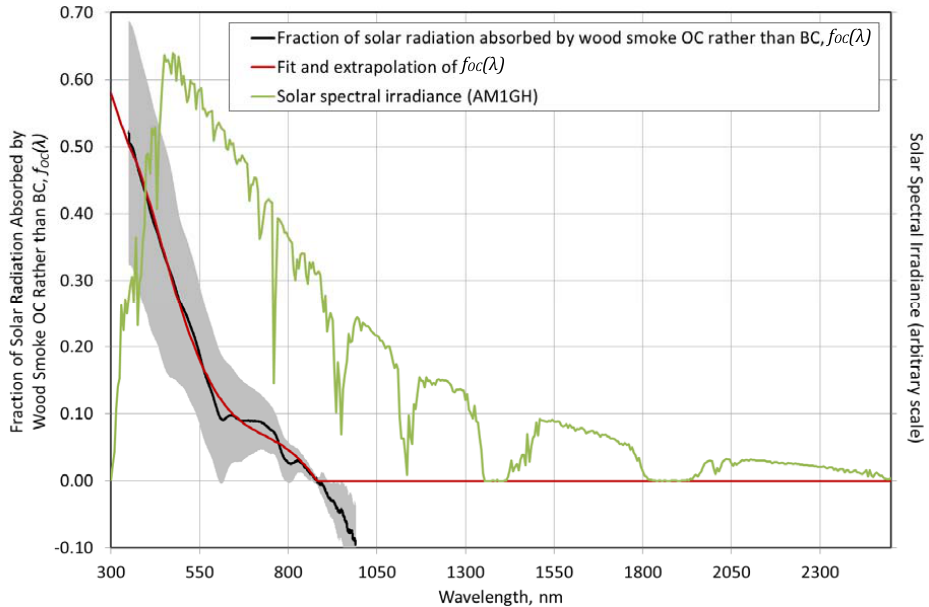
Fig. 3. Fraction of solar radiation absorbed by organic carbon rather than black carbon in residential wood smoke particulate matter, f OC ( λ ): (black line and gray region) average values for 115 samples ± 1 standard deviation and (red line) a model fit and extrapolation of the data. Also shown (green line) is the clear sky air mass one global horizontal (AM1GH) solar spectrum at the earth’s surface (Levinson et al., 2010).